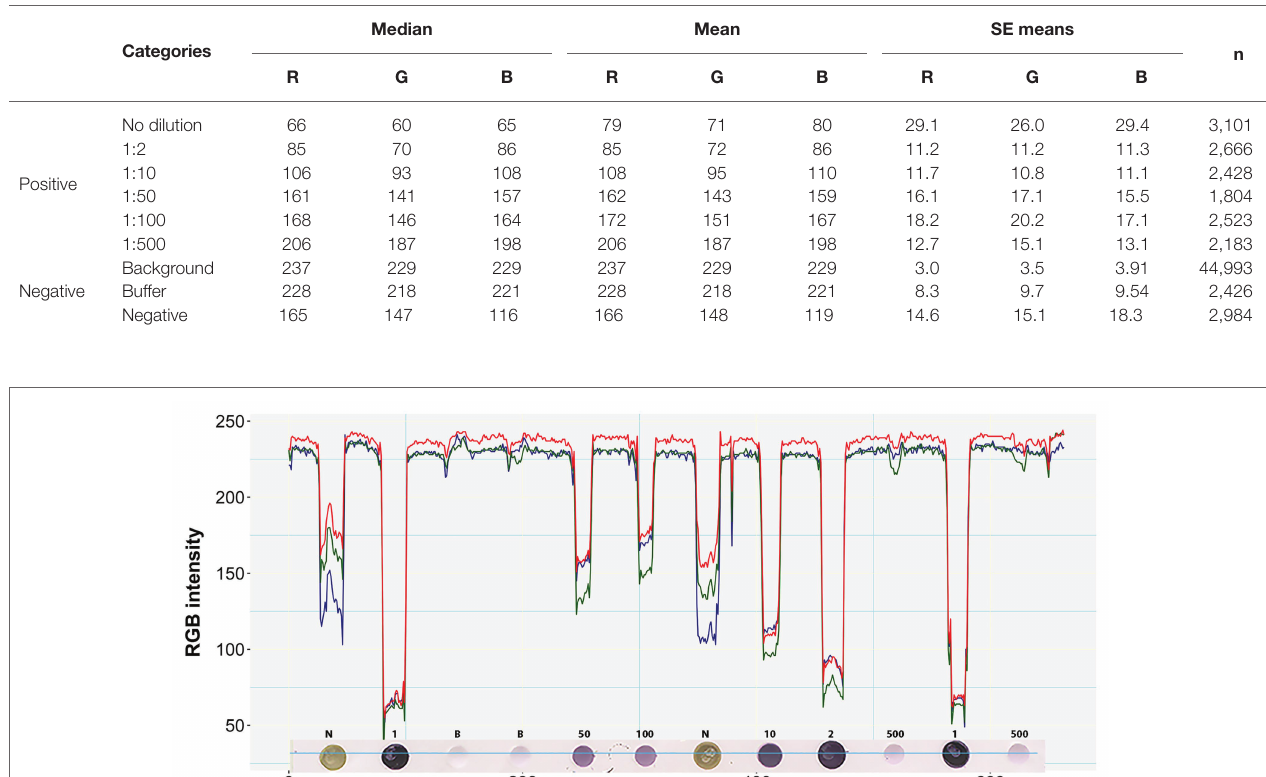
TABLE 2 | Median, means, and SE of means of pixel color categories in which outliers have been removed ( n =